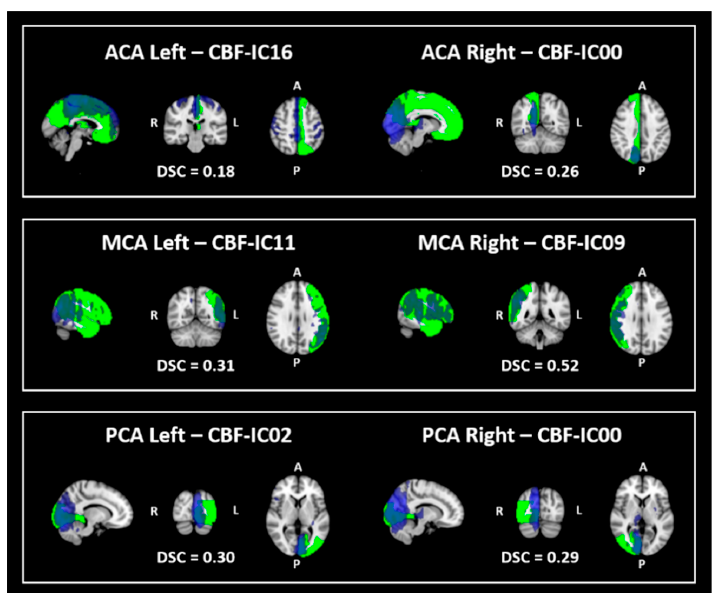
Figure 3. The figure shows the comparison between CBF-ICs (in blue) and the VT atlas (in green). Specifically, comparison between CBF-ICs and the left and right ACA are reported in the top panel, the middle panel shows the comparison between CBF-ICs and left and right MCA, the bottom panel shows the comparison between CBF-ICs and left and right PCA. Legend: CBF-ICs = independent components derived from CBF maps; VT = vascular territories, ACA = anterior cerebral artery, MCA = middle cerebral artery; PCA = posterior cerebral artery; DSC = Dice Similarity Coefficient.